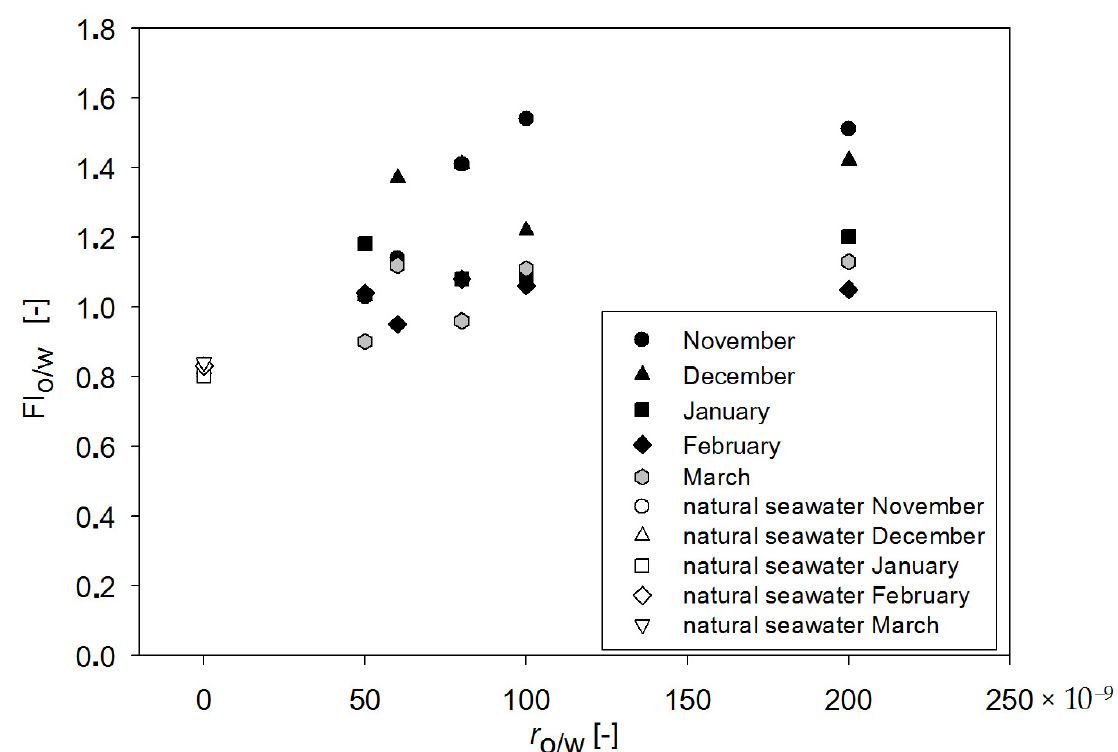
Figure 6. FI o/w values for natural seawater and seawater contaminated by a mixture of oil as a